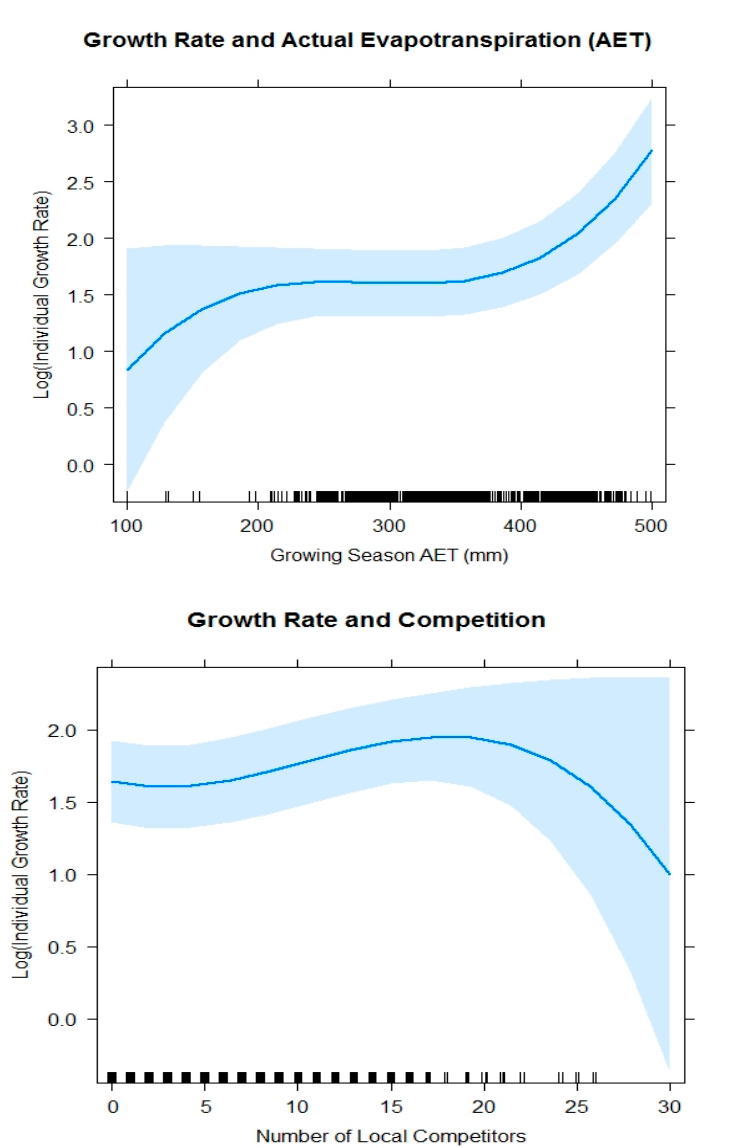
Figure 5. Plotted fixed effects of the best model for log (Individual Growth Rate) ~ AET 3 + Number of Local Competitors 3 + random (Unit) with confidence interval = 0.95 in light blue.